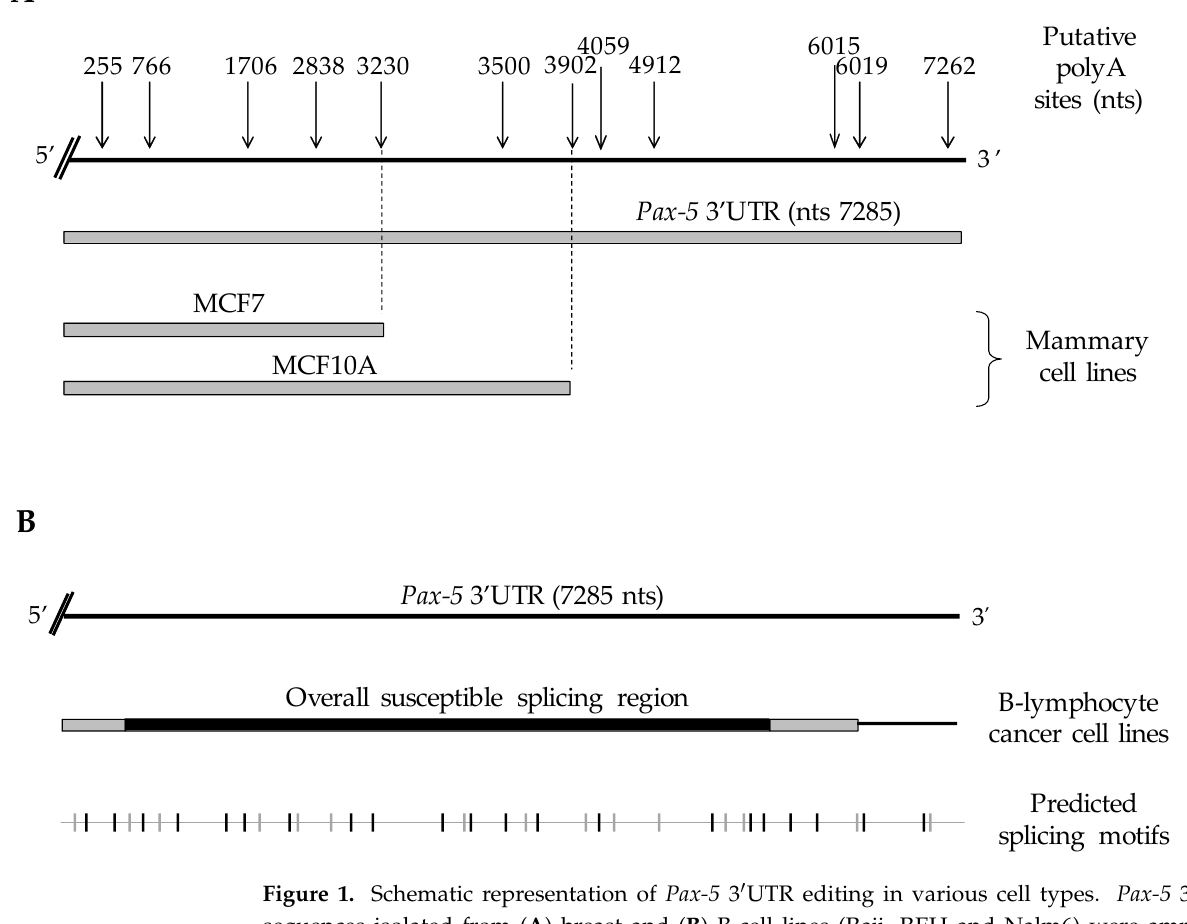
Figure 1. Schematic representation of Pax-5 3 (cid:48) UTR editing in various cell types. Pax-5 3 (cid:48) UTR sequences isolated from ( A ) breast and ( B ) B-cell lines (Raji, REH and Nalm6) were amplified using 3 (cid:48) RACE, sequenced and aligned with the genomic Pax-5 3 (cid:48) UTR (top strand) marked with the predicted alternative polyA sites (top arrows) in relation to their nucleotide position after the stop codon. The bottom line represents a computational analysis of Pax-5 3 (cid:48) UTR putative splicing elements where the gray vertical nicks represent acceptor sites, whereas black vertical nicks represent donor elements for splicing sites (http://regrna2.mbc.nctu.edu.tw) (accessed on 20 March 2019).